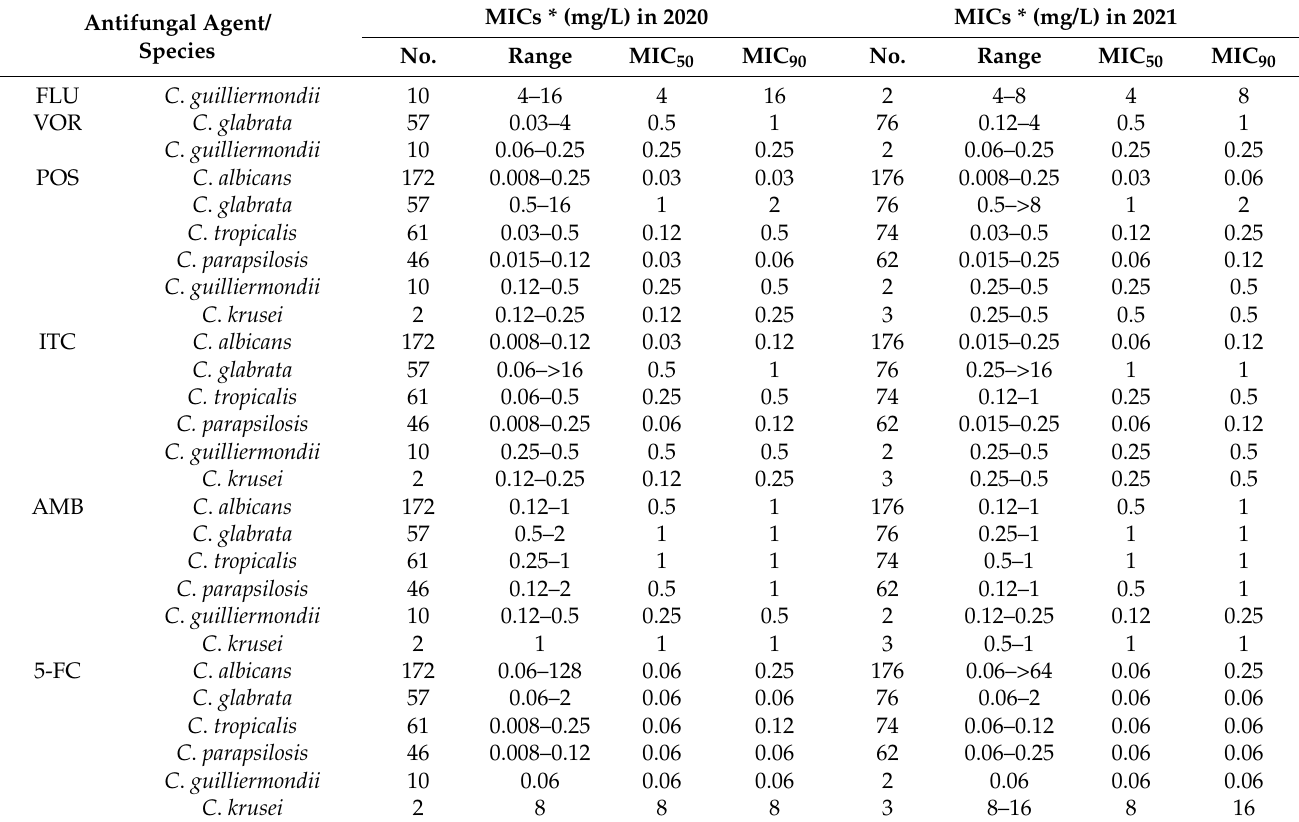
Table 3. Antifungal susceptibilities of 741 isolates of six common Candida species which clinical breakpoints are not available in CLSI M60.